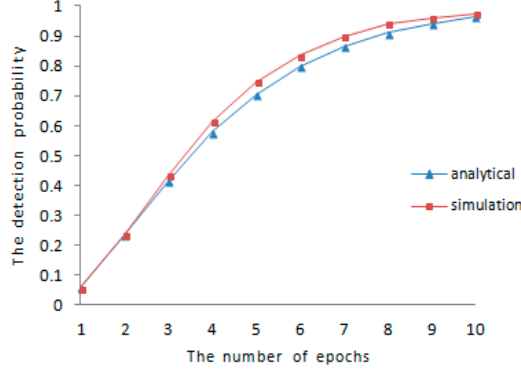
Figure 1. Comparison of detection probability ( R = 40, N = 1000).